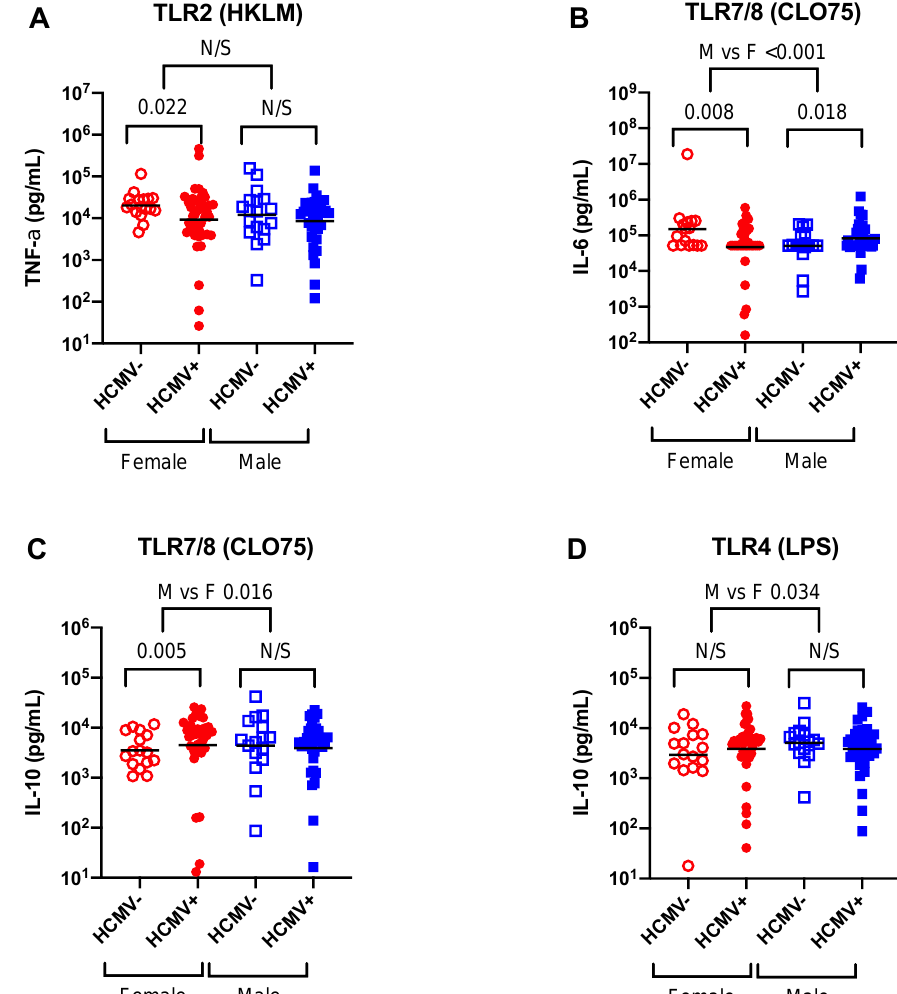
Figure 1. The significant sex-differential cytokine responses in the study. Whole heparinized blood was stimulated for 16 h with TLR ligands, and cytokine concentrations were measured in culture supernatants by multiplex assay. ( A ). HCMV+ females had lower TNF-α responses to TLR2 (HKLM) stimulation than HCMV- females. ( B ). HCMV+ females had lower IL-6 responses to TLR7/8 (CLO75) stimulation than HCMV- females, while males had the opposite pattern of higher responses in the HCMV+ group. There was a significant difference in IL-6 responses to CLO75 between males and females. ( C ). HCMV+ females had greater IL-10 production to CLO75 than HCMV- females, whereas HCMV+ and HCMV- males had comparable CLO75-stimulated IL-10. There was a significant difference in IL-10 responses to CLO75 between males and females. ( D ). There was no significant difference in IL-10 responses to TLR4 (LPS) stimulation between HCMV+ and HCMV- infants for males or females, but comparing male and female responses did show a significant difference. The individual symbols equal individual infants and the bar shows the geometric mean value in pg/mL. N/S = not significant, M = males and F = females.